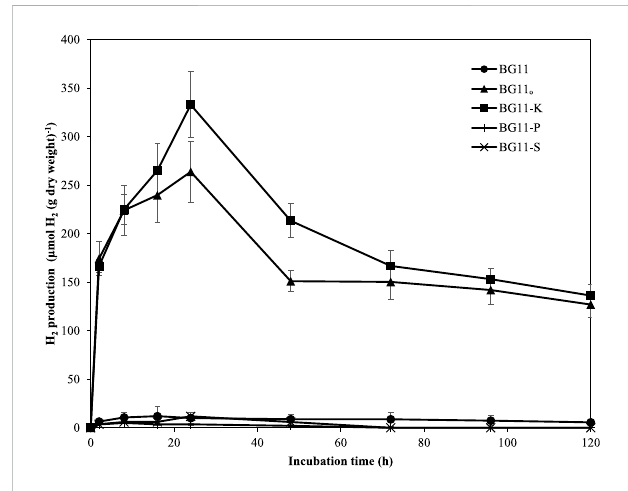
FIGURE 1 H 2 production (µmol H 2 g dry wt − 1 ) by A. halophytica incubated for (cid:129) various times in BG11 ( ), BG11 0 ( ▲ ), BG11-K ( ■ ), BG11-P (+), and BG11-S (*)mediumunderdarkanaerobiccondition.Dataaremeans±SD( n